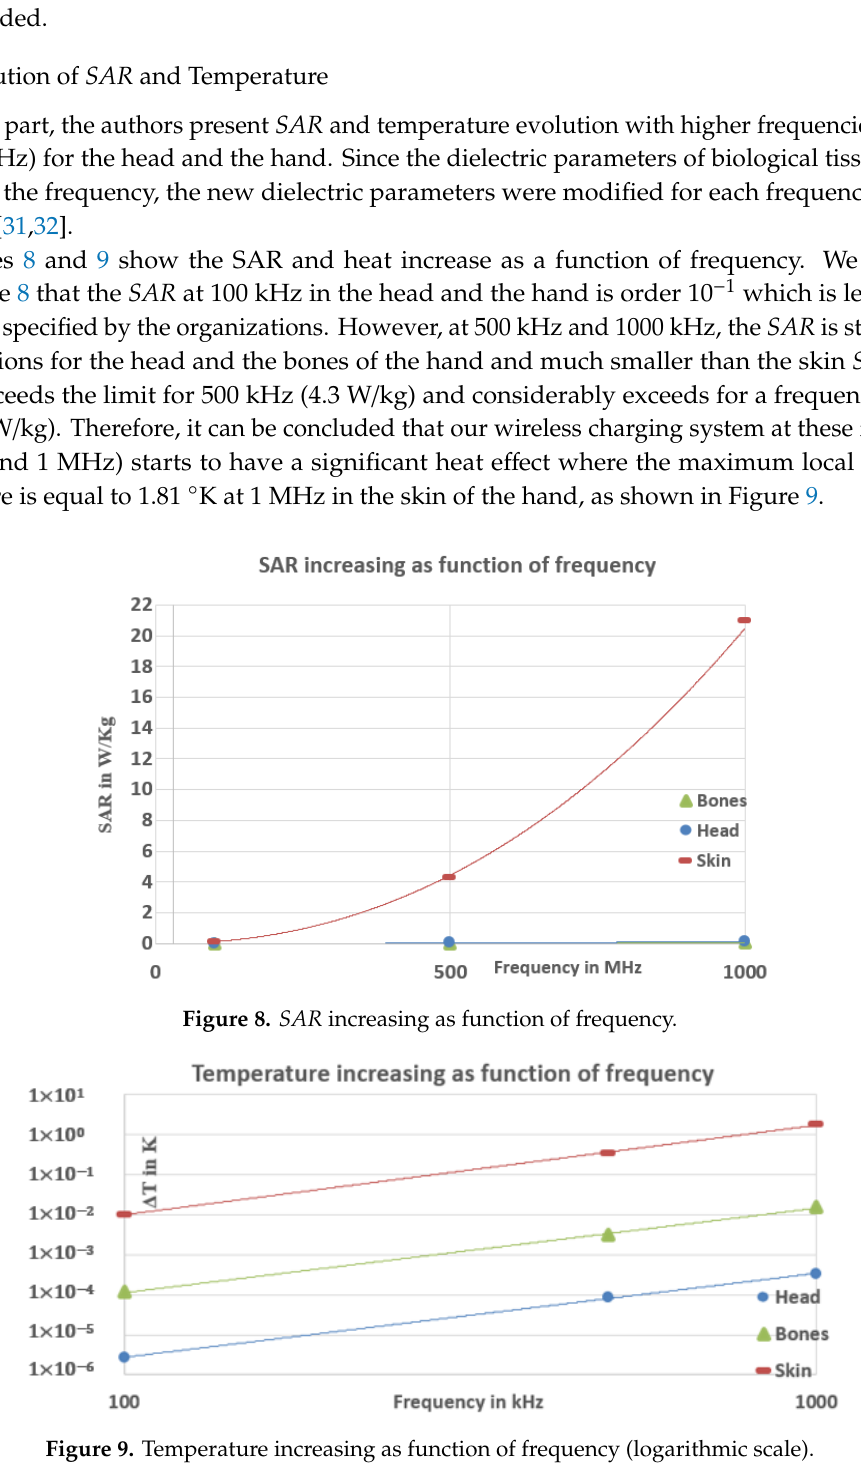
Figure 9. Temperature increasing as function of frequency (logarithmic scale).